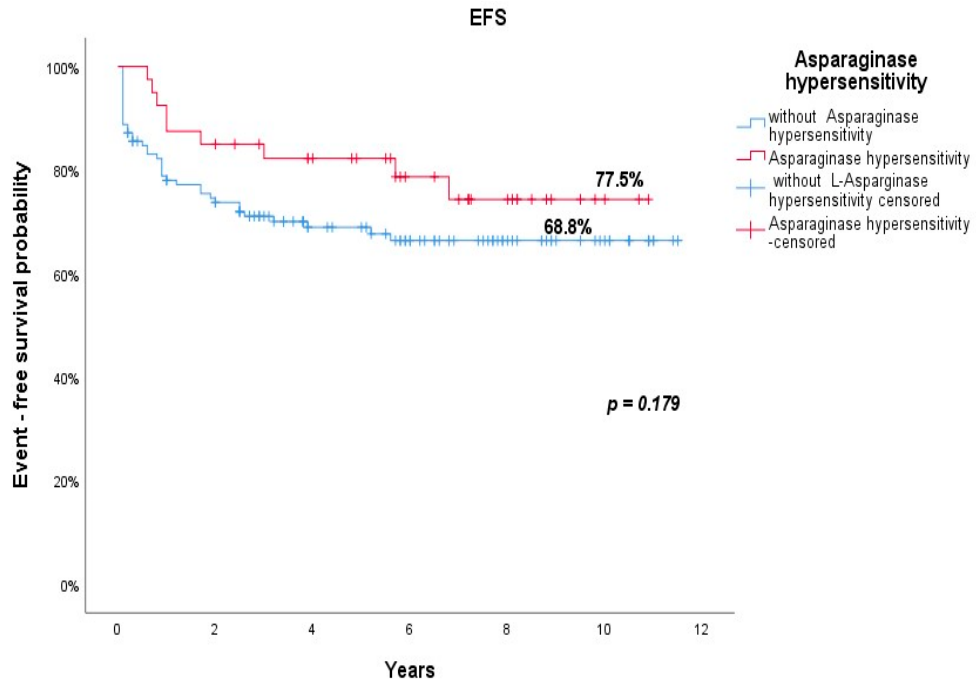
Figure 3. EFS of patients with (red line) and without (blue line) clinical hypersensitivity.